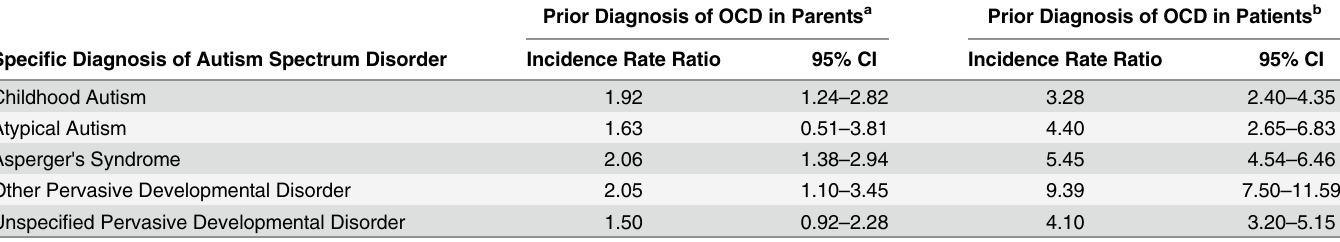
Table 1. Incidence Risk Ratio of Specific Diagnoses of Autism Spectrum Disorders in Relation to Individual and Parental Diagnosis of Obsessive- compulsive Disorder (OCD; 1994 – 2012). Prior Diagnosis of OCD in Parents